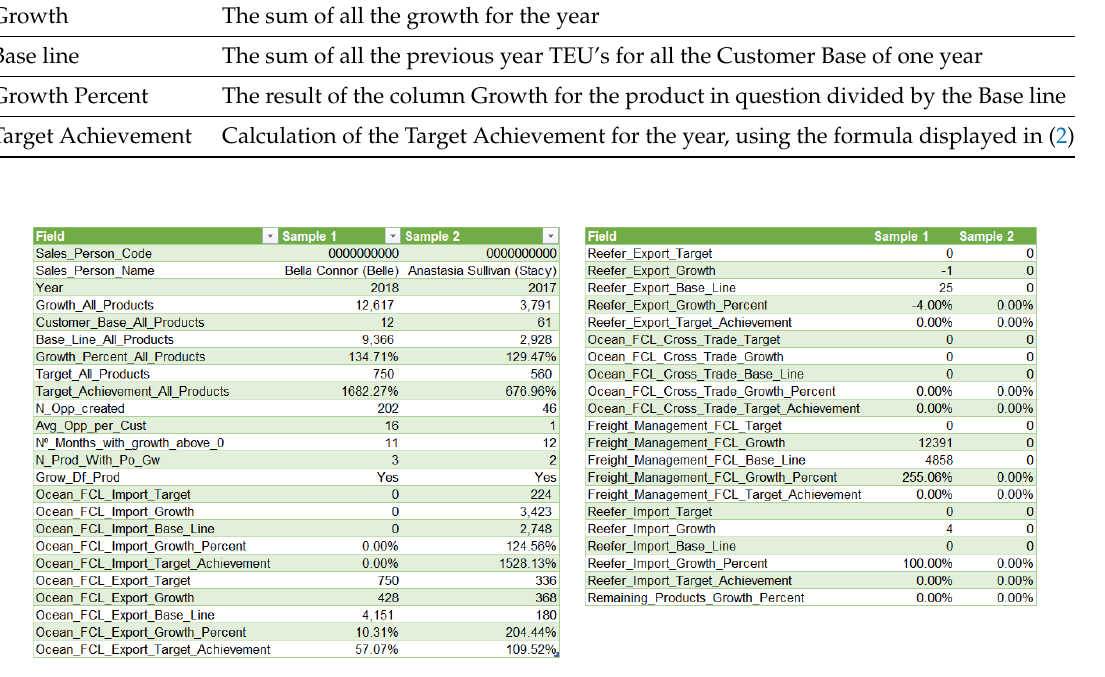
Figure 6. Sample of report